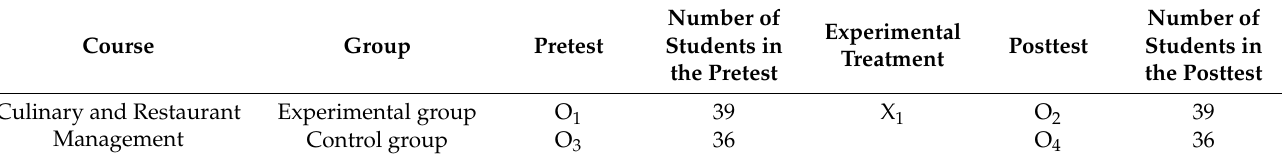
Table 1. Summary of the experimental design.